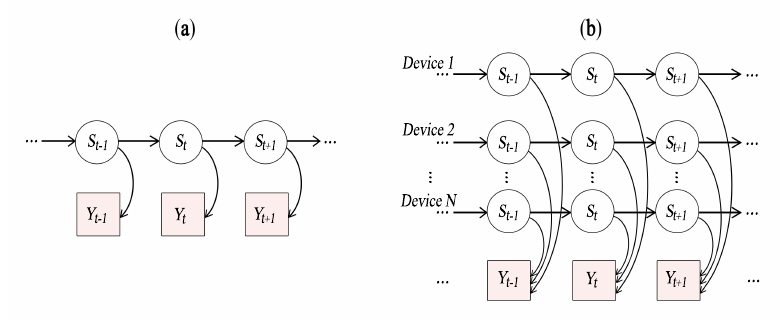
Figure 1. ( a ) the single Hidden Markov Model; ( b ) the additive Factorial Hidden Markov Model. Image adapted from [8]. Copyright 1997, Kluwer Academic